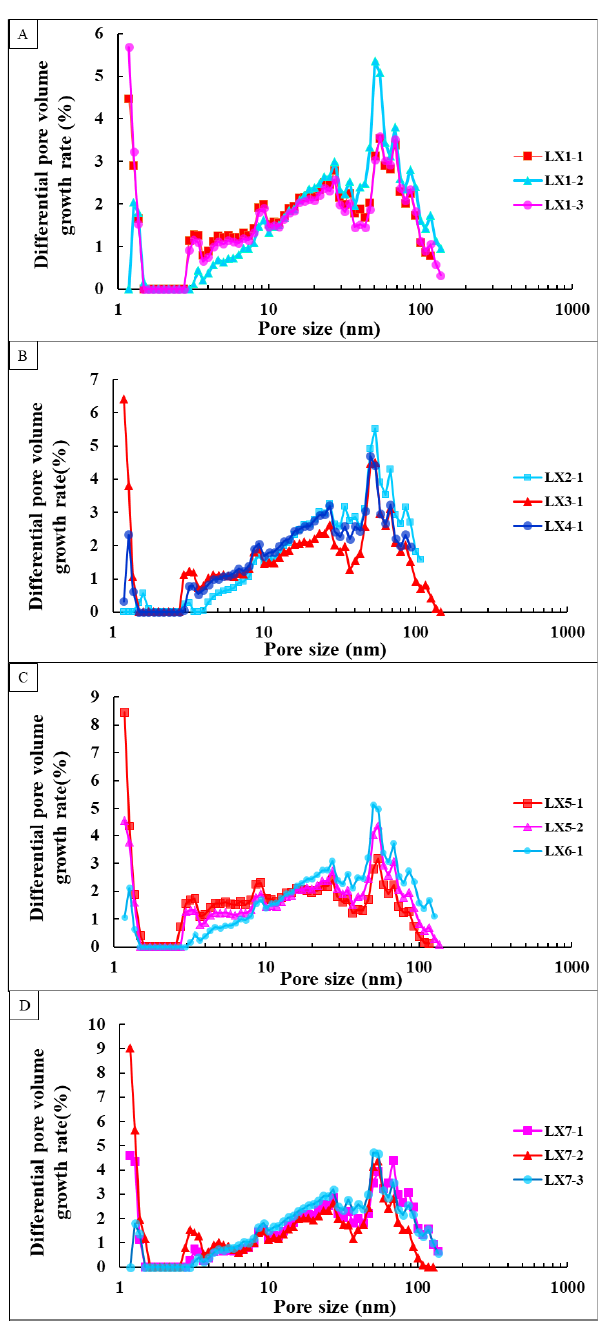
Figure 7. Pore size distribution of the Taiyuan Formation shale: ( A ) LX1-1, LX1-2, LX1-3; ( B ) LX2-1, LX3-1, LX4-1; ( C ) LX5-1, LX5-2, LX6-1; ( D ) LX7-1, LX7-2, LX7-3 based on the nitrogen adsorption